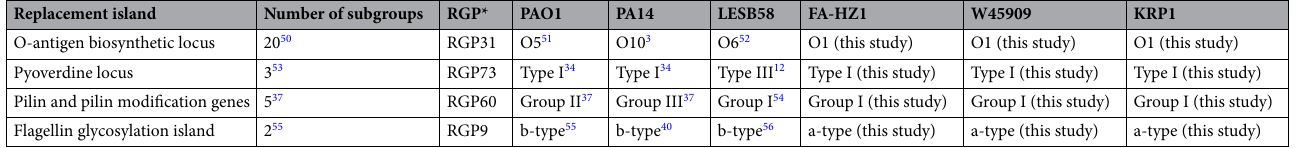
Table 3. Replacement islands in P. aeruginosa. *RGPs 1–62 30 ; RGPs 63–80 32 .